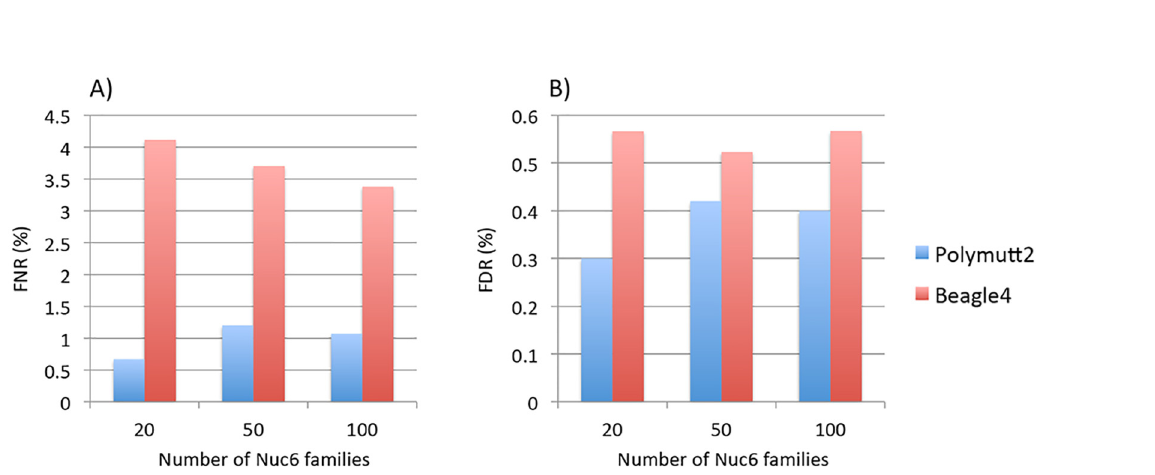
Fig 4. The FNR (%) in Panel A) and FDR (%) in Panel B) of heterozygous genotypes at variant sites with MAF < 0.02 for Polymutt2 and Beagle4 calls for different numbers of simulated Nuc6 pedigrees at 10X coverage.